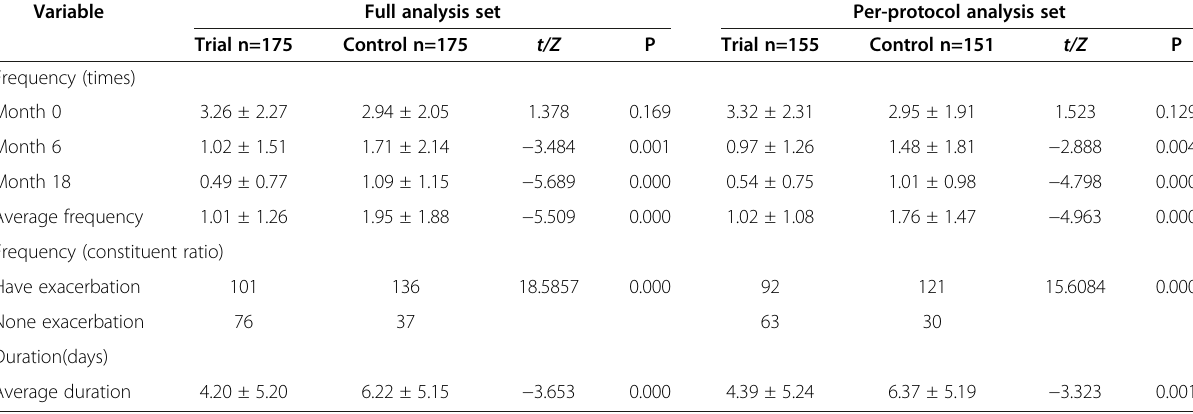
Table 4 Comparison of the frequency and duration of acute exacerbation